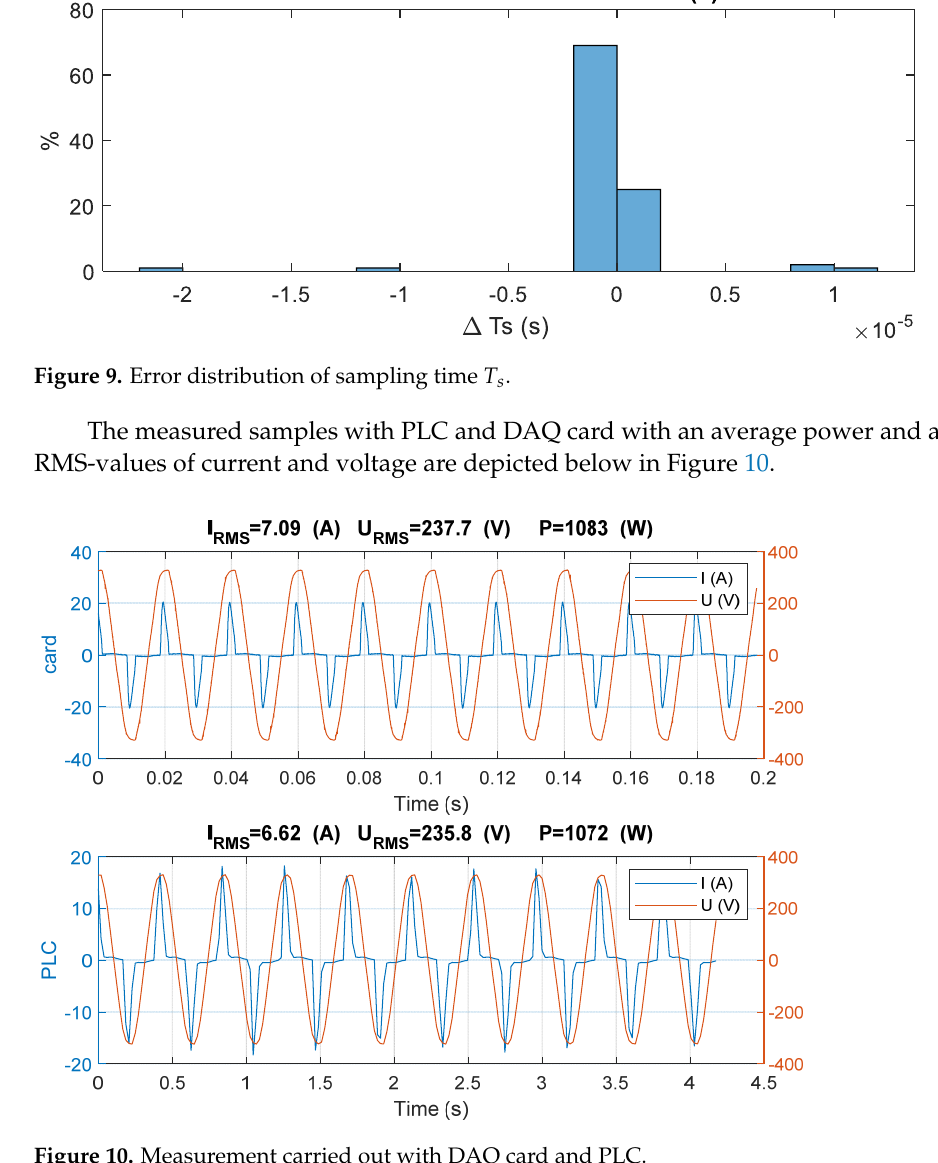
Figure 10. Measurement carried out with DAQ card and PLC.